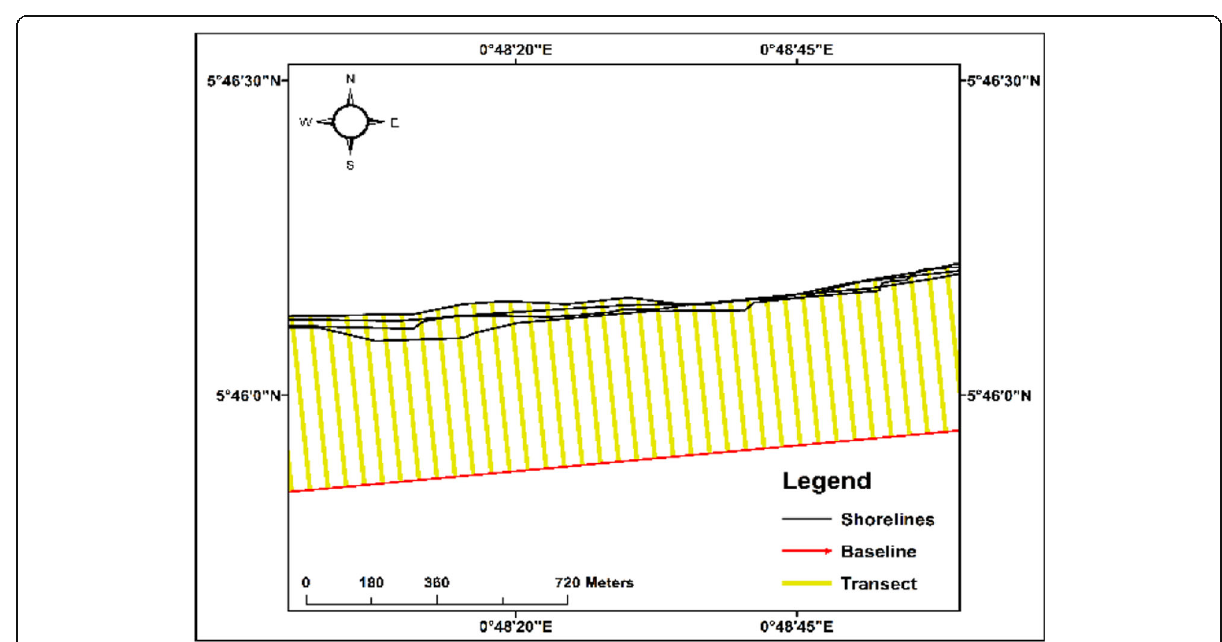
Fig. 6 Transects cast along the baselines and shorelines